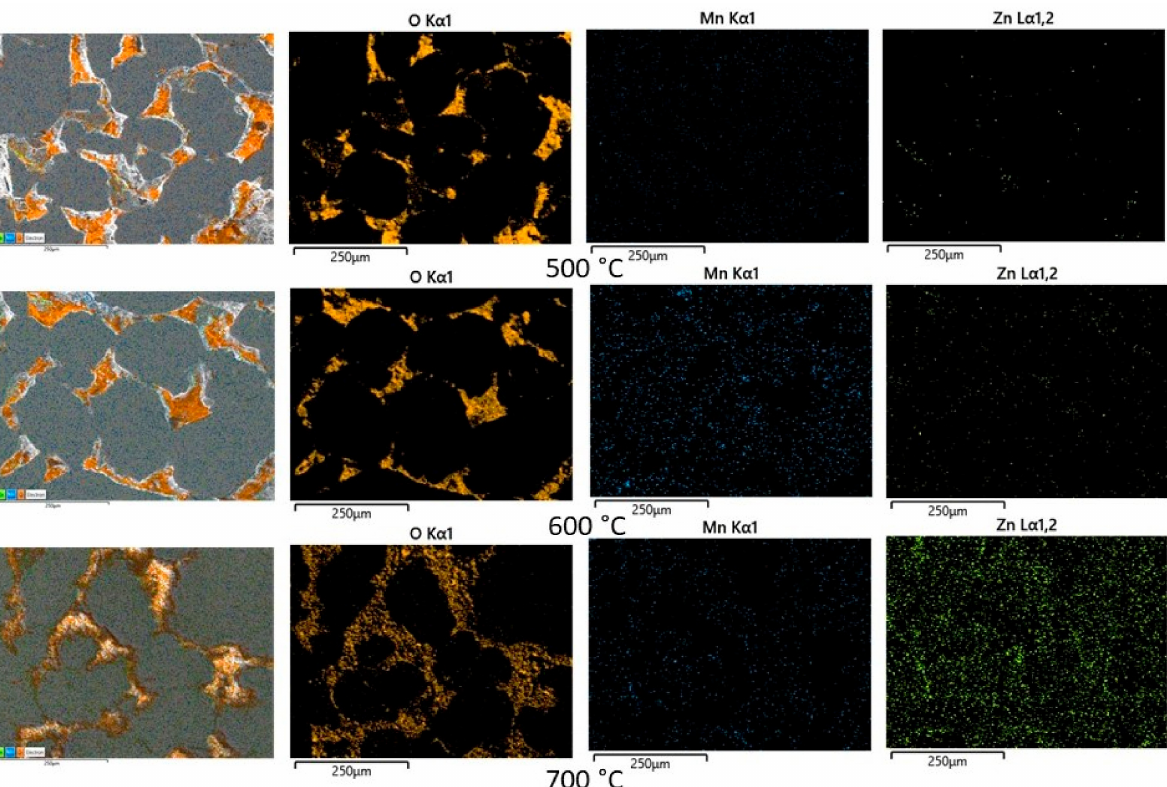
Figure 7. The influence of the sintering temperature on the microstructure of the Ni 3 Fe/Mn 0.5 Zn 0.5 Fe 2 O 4 (3 wt. %) SPS-ed composite compacts. Sintering time—0 min. On the left side of each series is the SEM image over which the O, Mn, and Zn distribution maps are